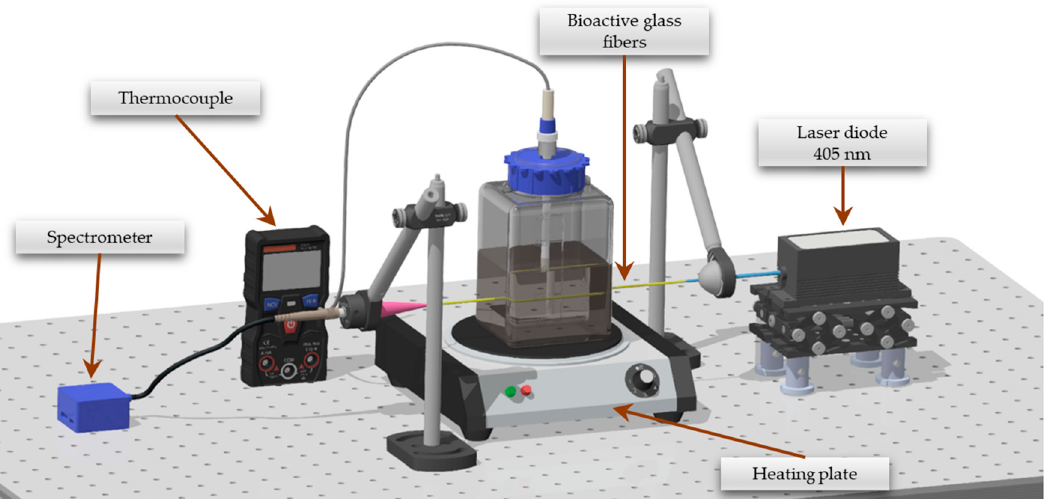
Figure 1. The measuring station for the optical method of determining the degradation process of bioactive glass fibers.